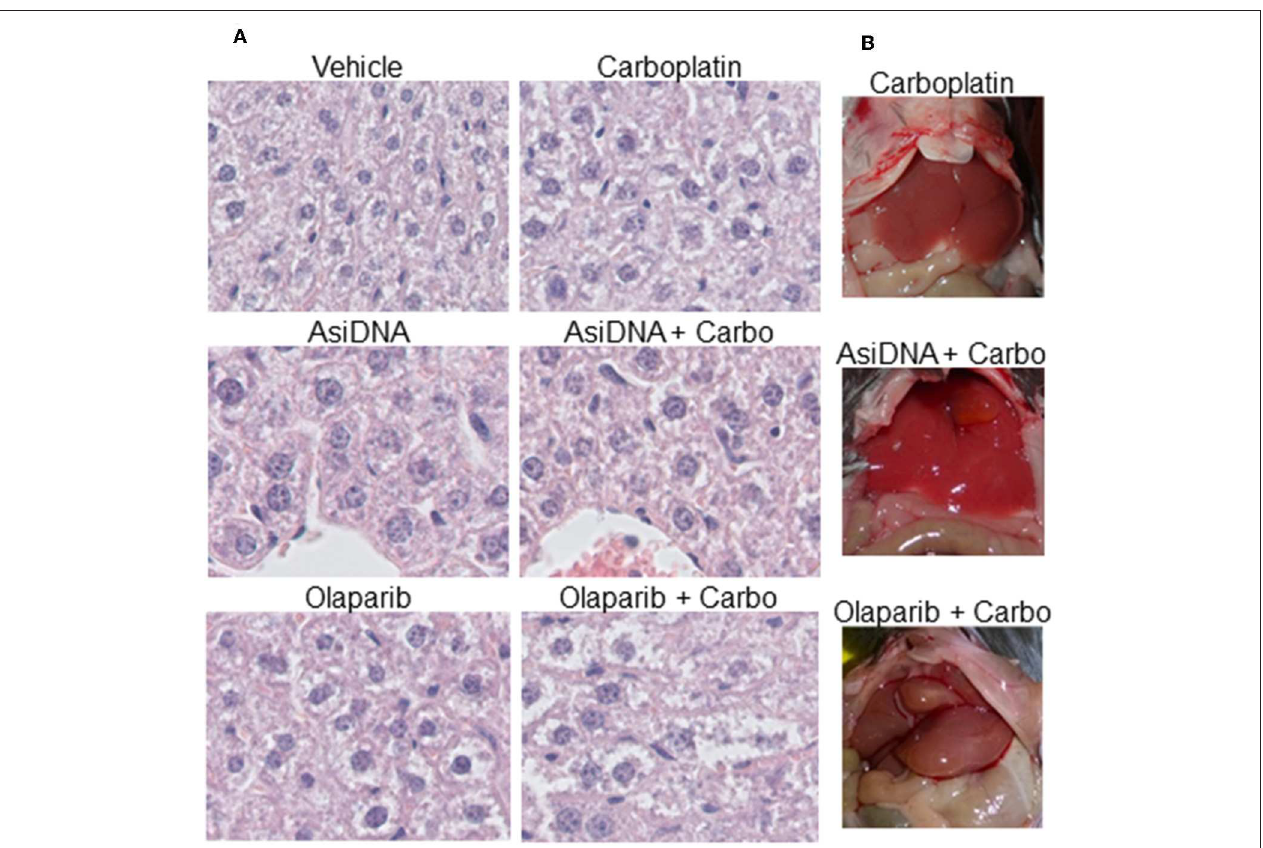
FIGURE 6 | Hepatomegaly in mice treated with a combination of olaparib and carboplatin. (A) Example of histology samples of liver of mice exposed to various treatments, (B) macroscopic view of treated